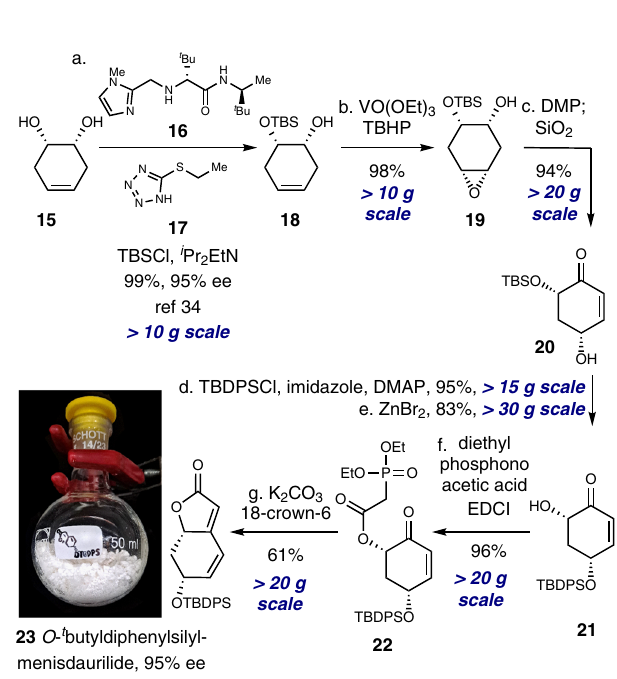
Fig. 2 | Select prior syntheses and derivatization of allosecurinine and our synthetic blueprint for C4-oxygenated securinine-type natural products. a Busqué and de March ’ s biosynthetically inspired synthesis of allosecurinine (ref. 19); b Gademann ’ s biosynthetically inspired synthesis of secu ’ amamine E and